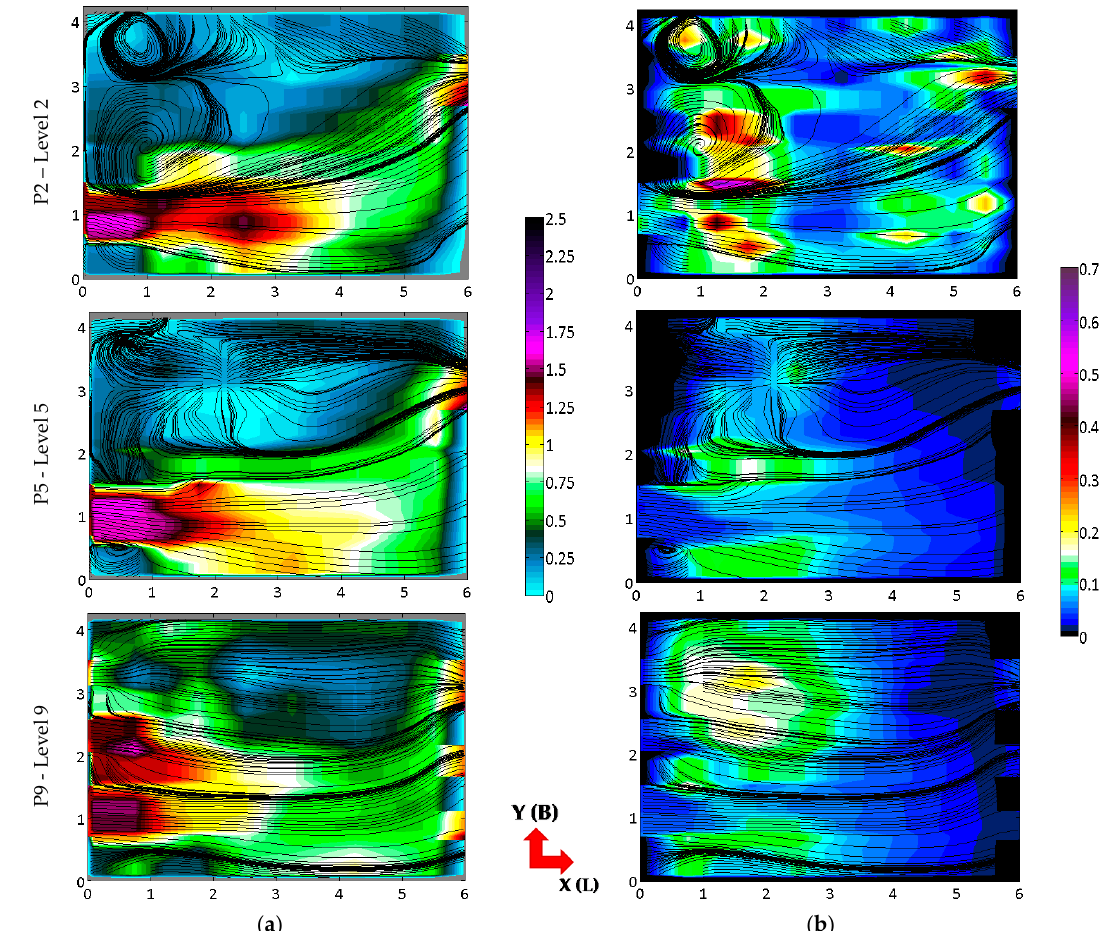
Figure 4. Characteristic section at the actual scale. ( a ) Average velocities (m/s); ( b ) TKE (m 2 /s 2 ); dimensions on the axes (m). Model B.